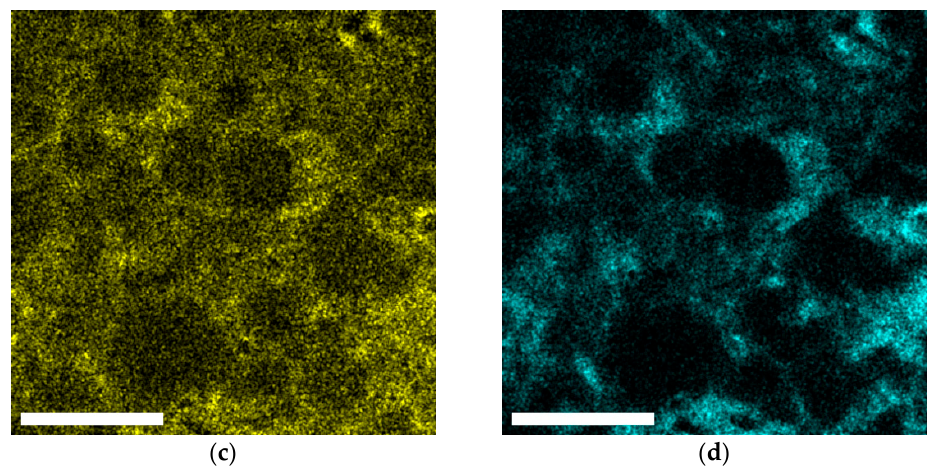
Figure 5. Ettringite transformation in the binder matrix after early-stage fatigue: ( a ) HAADF-STEM image indicating where spectra were extracted; ( b ) Corresponding EDS spectra; ( c ) EDS map of aluminum distribution; ( d ) EDS map of sulfur distribution. Scale bar is 500 nm.